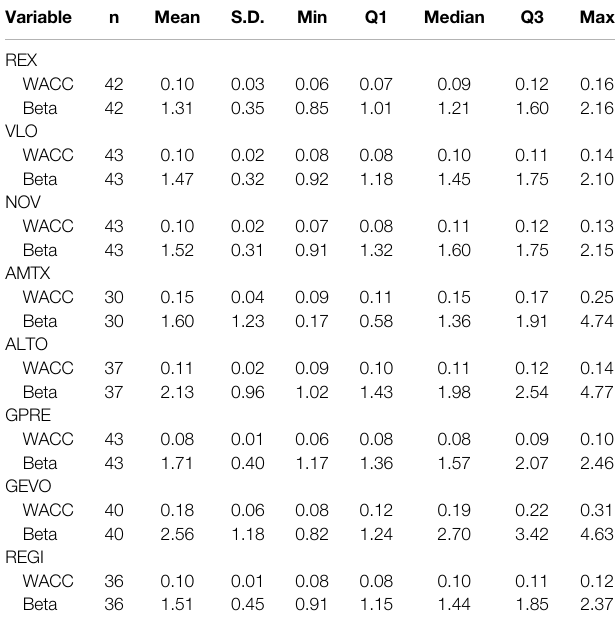
TABLE 2 | Statistics of WACC and beta across fi rms in the sample from 2010 to 2020. Variable